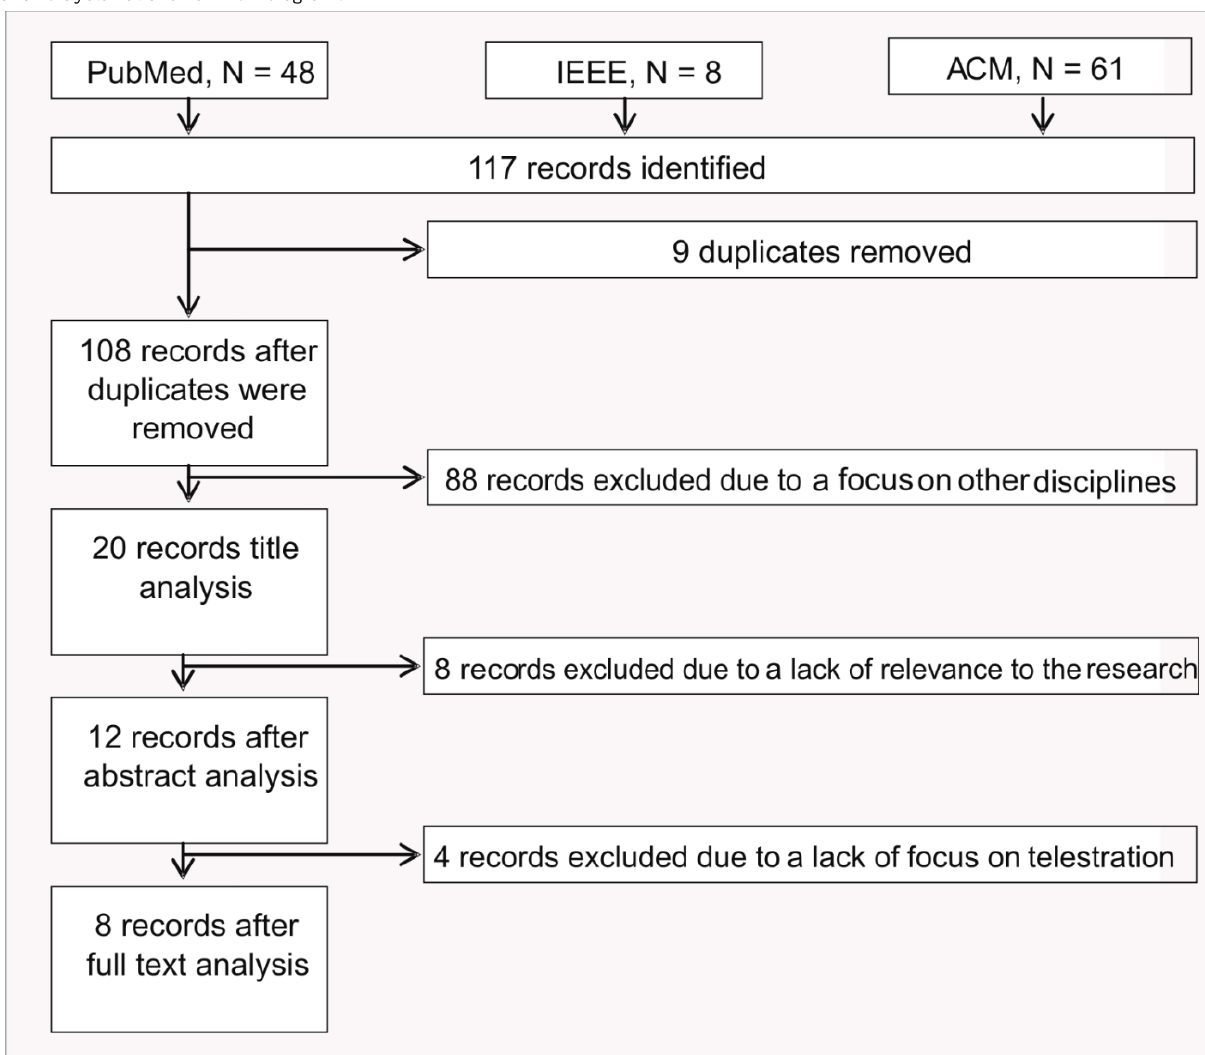
Figure 2. Systematic review flow